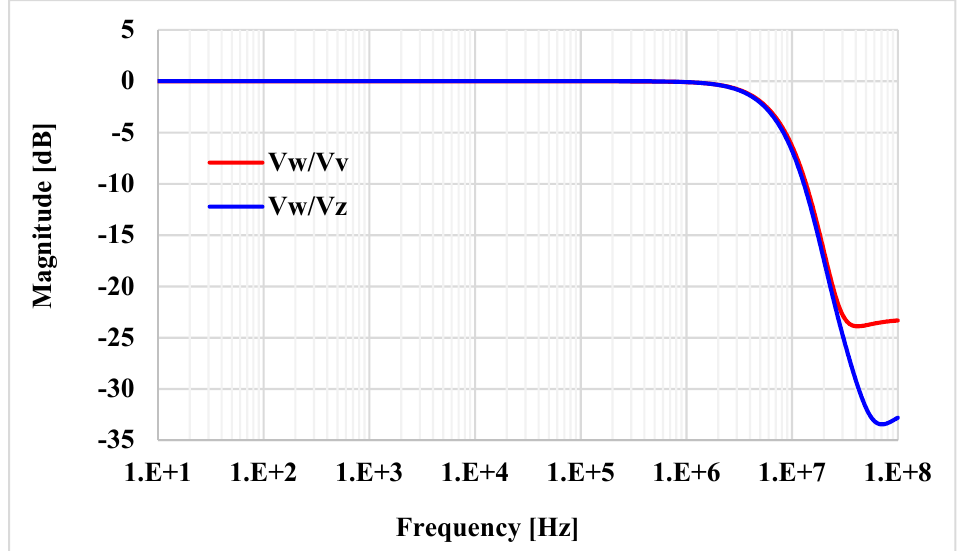
Figure 8. The frequency responses of V w / V v and V w / V z .